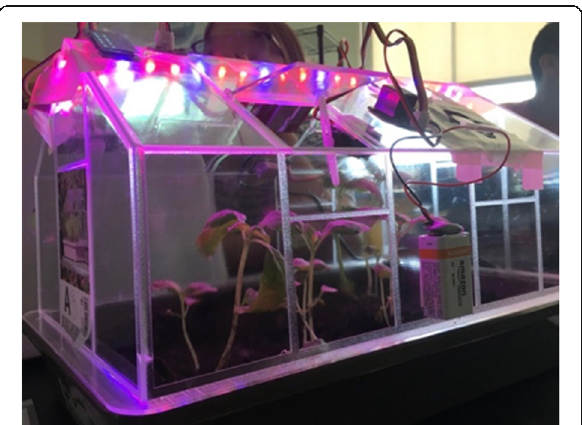
Fig. 1 A typical example of a completed smart greenhouse. The lights, microcontroller, and battery are placed on the exterior, whereas plants, sensors, and most actuators (fans, pumps, etc.) reside in the